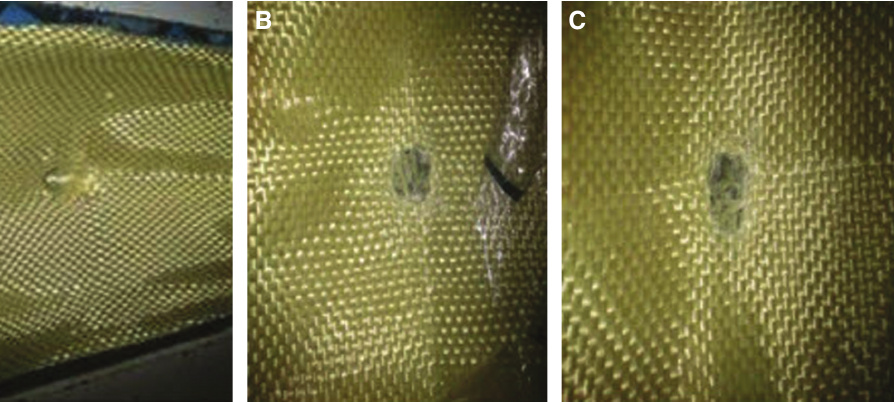
Figure 10 Specimen on the fixture after impact test by gas gun: (A) neat, (B) made by VIP method, (C) handmade with 3:1